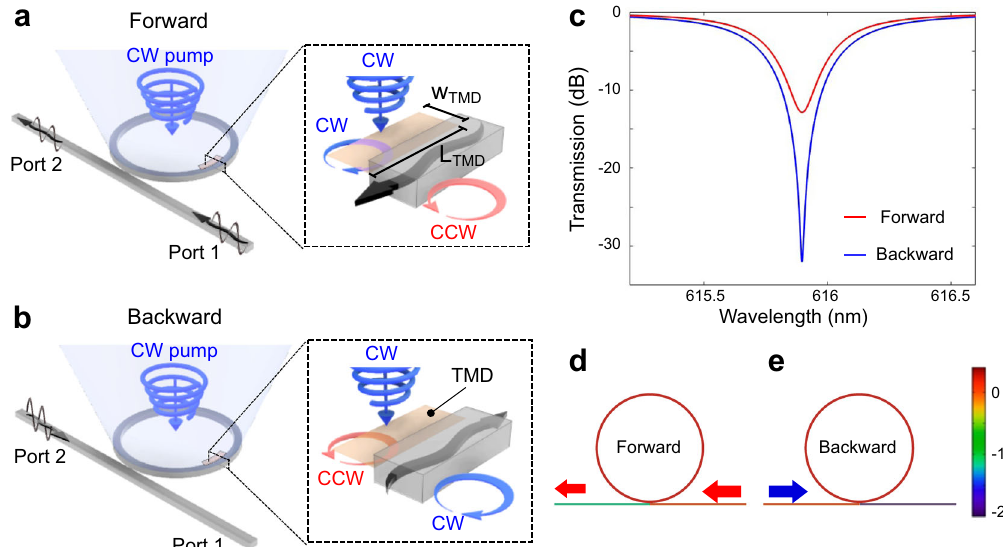
Fig. 4 All-optical isolator device design and its operation principle. a , b SiN ring resonator loaded asymmetrically by a transition metal dichalcogenide (TMD) monolayer (on the inner side of the ring only to maximize asymmetric loss), which explains nonreciprocal transmission due to different absorption of clockwise (CW) and counter-clockwise (CCW) modes in the ring resonator. c Nonreciprocal transmission through the waveguide with forward and backward transmission shown by blue and red lines, respectively. The ring radius R = 15 μ m, therefore the trip distance L = 2 π R , t = 0.816, and a + = 0.824, a _ = 0.888, which correspond to the experimentally extracted surface conductivity tensor σ xx = 1.10 × 10 − 3 and σ xy = 1.92 × 10 − 4 with parameters α = 4.69 × 10 4 1/m, δ = 1.13 × 10 4 1/m, L = 3.3 μ m, the width of the TMD monolayer is w = 50 nm. d , e Power density in the all-optical isolator for TMD forward ( d ) and backward ( e ) propagating waves, respectively, as calculated from coupled mode theory